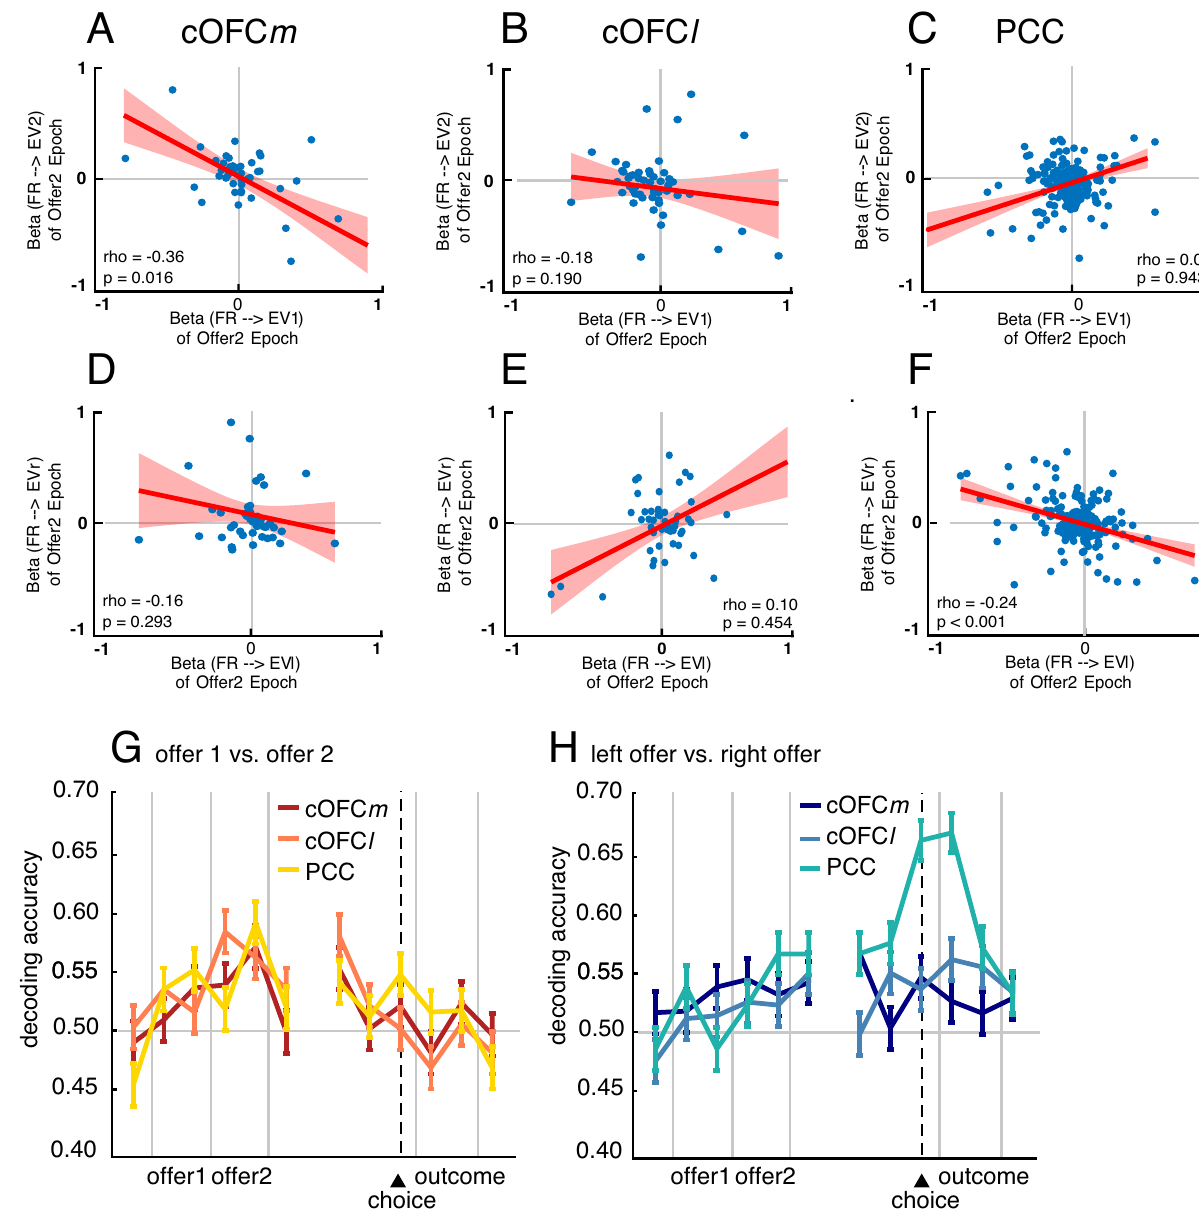
Fig. 3 Neural computations. A – F Scatter plots demonstrating population spreads for regression coef fi cients. Each dot represents one neuron; abscissa and ordinate represent regression coef fi cients for distinct (and uncorrelated) regressions. Solid red line: fi tted Spearman correlation. Shaded area: 95% con fi dence interval. EV1 = expected value of fi rst offer; EV2 = expected value of second offer. A – C Putative mutual inhibition effects (Strait et al., 2014). Y - axis indicates regression coef fi cient for expected value of offer 2 regressed against fi ring rate in epoch 2. X -axis indicates regression coef fi cient for expected value of offer 1 against fi ring rate in epoch 2. D – F Putative mutual inhibition effects in a spatial framework (new analysis developed for